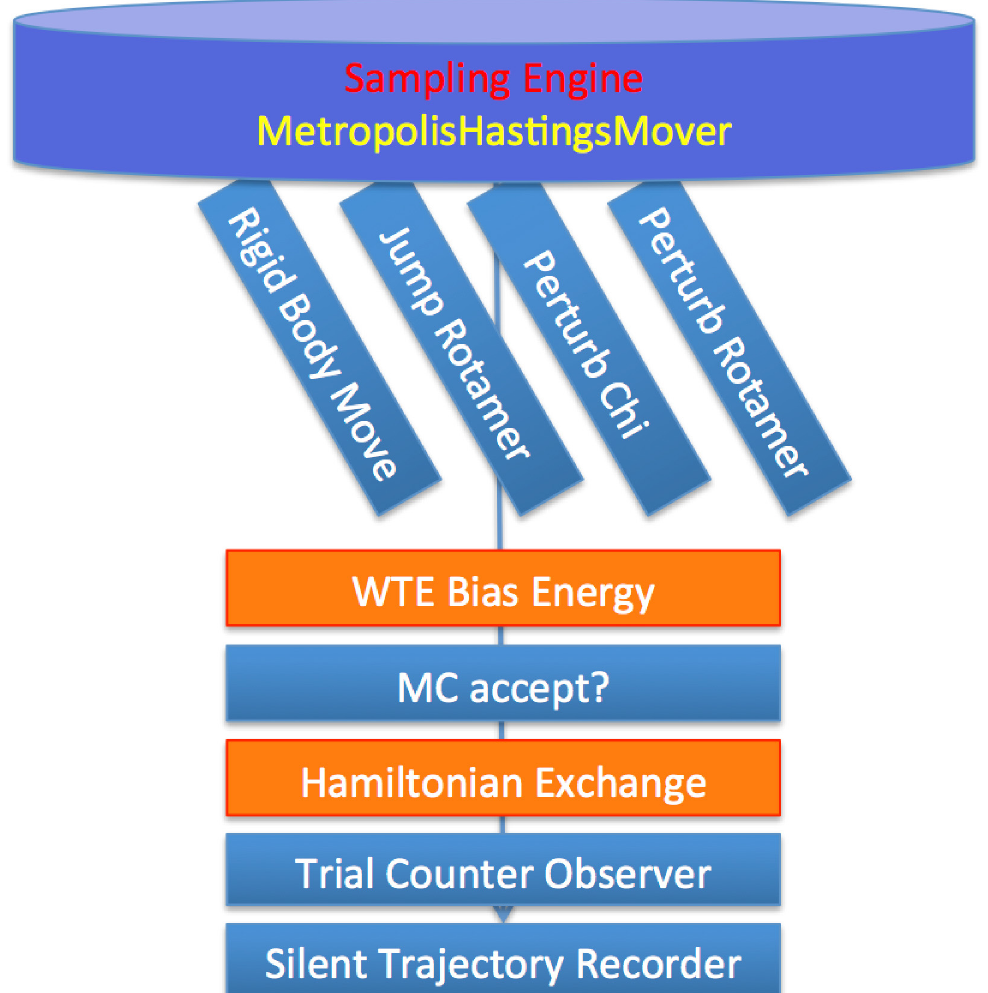
Fig 2. Workflow represented by combination of Rosetta modules and setup of the four docking protocols. The modules in orange, representing the enhanced sampling techniques of replica exchange and well-tempered ensemble, are only applied in the combined